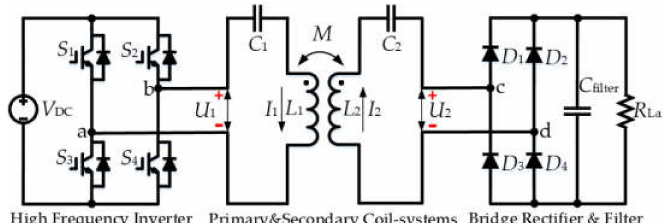
Figure 1. Two coils SS compensated WPT